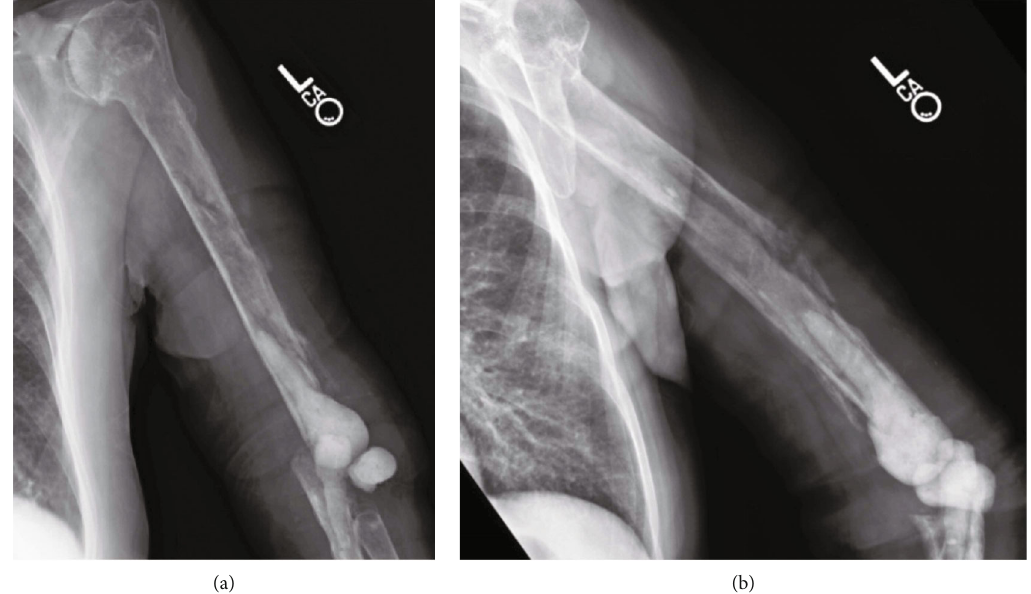
Figure 3: (a, b) Five-month postoperative images following fi rst-stage revision surgery. (a) AP humeral X-rays showing delayed healing of the humeral shaft fracture and antibiotic spacer of the humerus, ulna, and elbow joint. (b) Lateral humerus X-ray showing incomplete healing of the humeral shaft fracture.